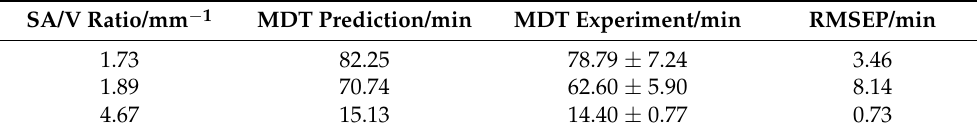
Table 5. Comparison of MDT: predicted vs. experimental data of the EVA-LD formulation ( n ≥ 3; x ± s).